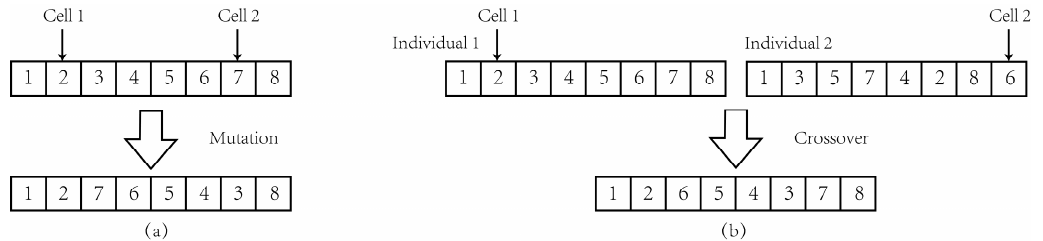
Figure 6. Execution process of Inver-Over operator: ( a ) Mutation; ( b ) Crossover.